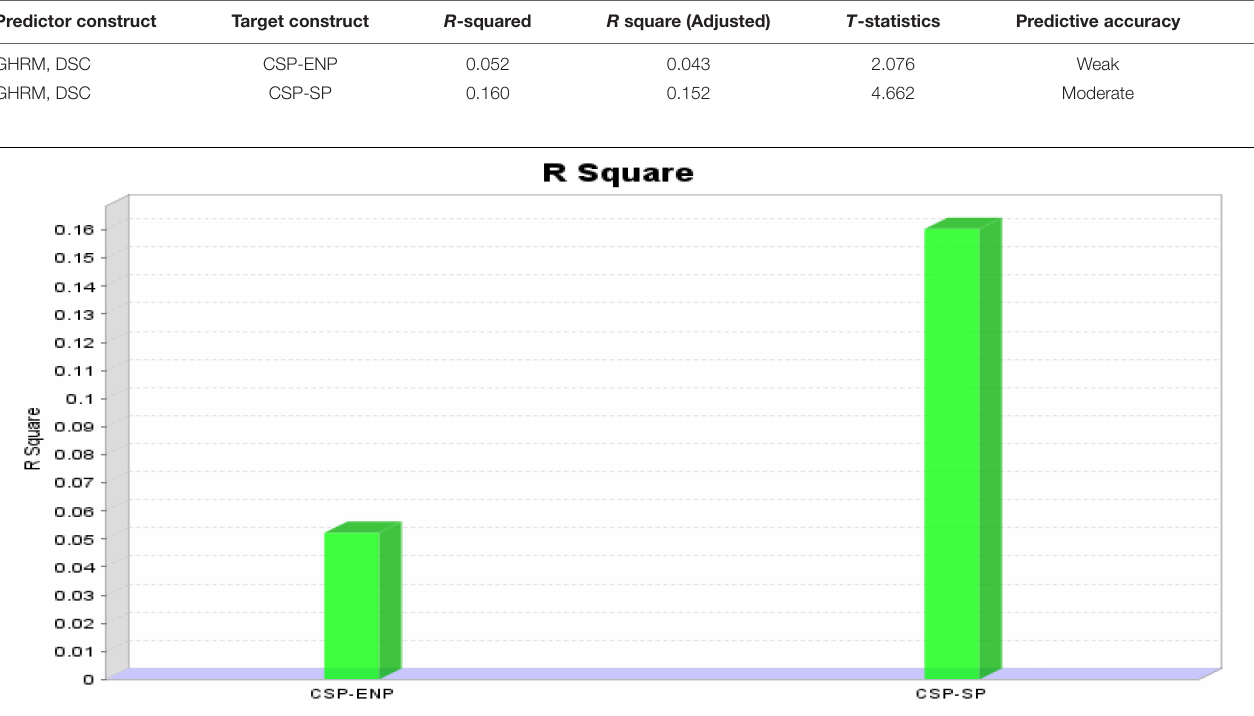
TABLE 6 | The R square value.